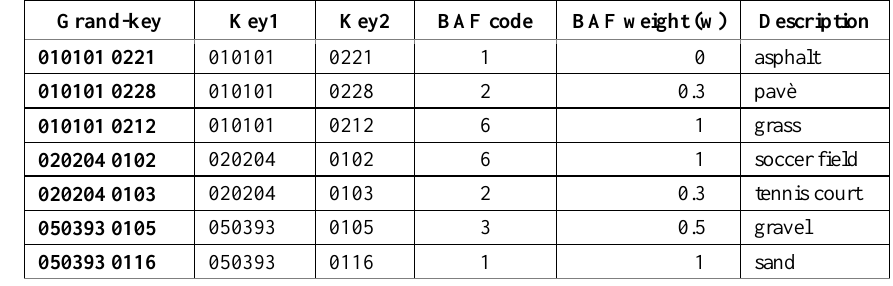
Table 4. An excerpt of the prepared look-up table